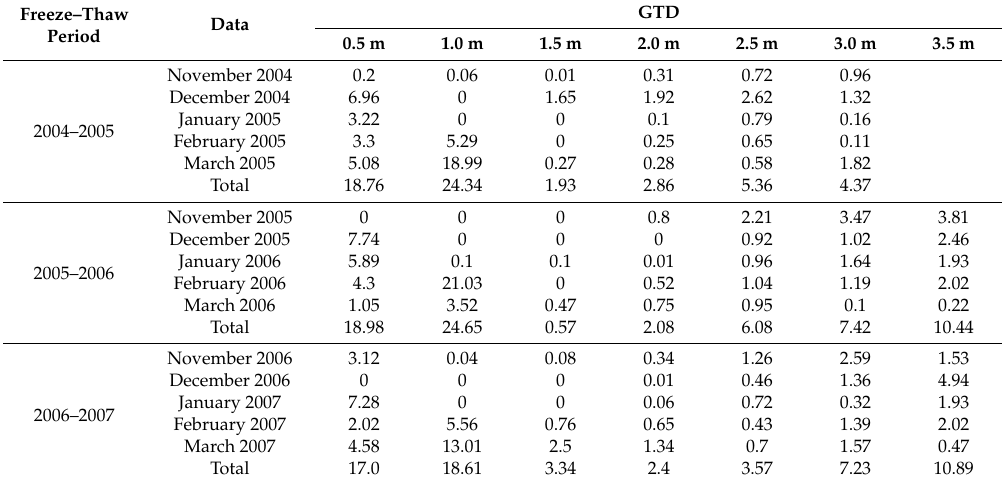
Table 9. Recharge to phreatic water with sandy soil during freeze–thaw periods. Unit: Millimeters.